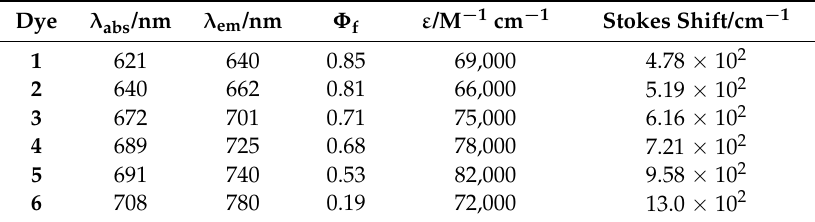
Table 1. Spectroscopic data of dyes 1 – 6 in dichloromethane (DCM). Dye λ abs /nm λ em